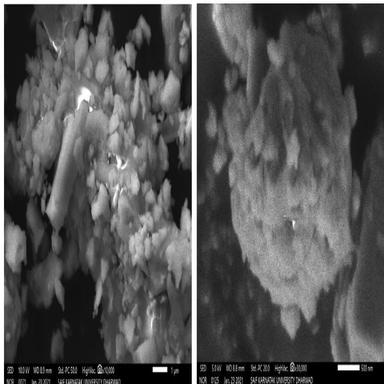
Scanning Electron Microscope (SEM) image of Lactic acid capped ZnS QDs; Formation of nanosized structures. (i) at magnification of 10,000 times, (ii) 30,000 times.